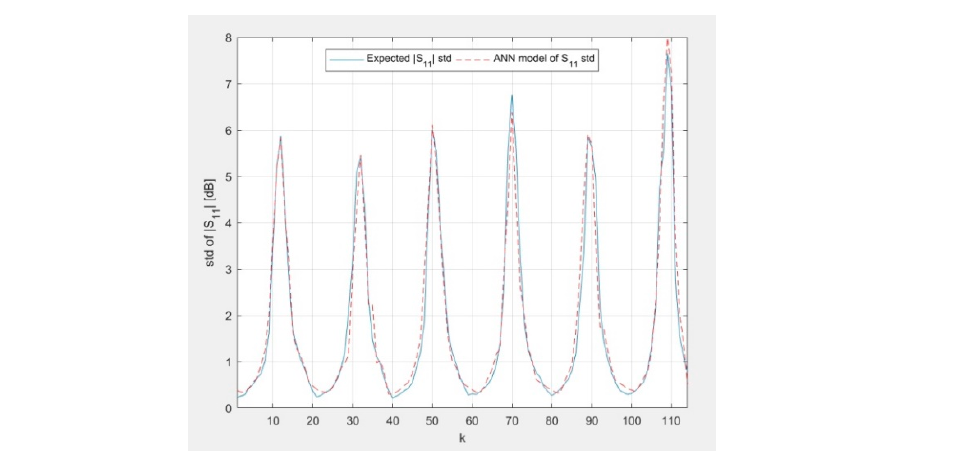
Figure 16. The expected and modeled mean of | S 11 | of an ordinary patch antenna for the range of the first set of testing data.